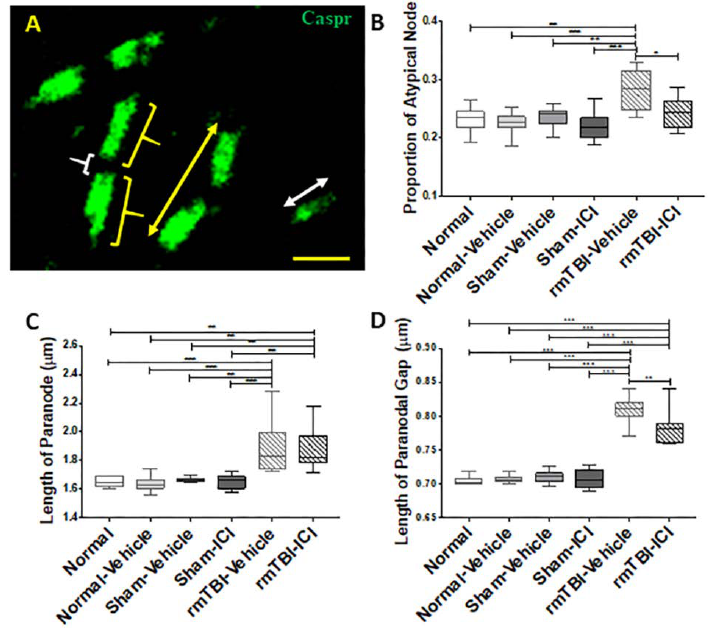
Figure 6. Analysis of the node of Ranvier integrity in the corpus callosum on day 11 following mTBI on days 1 and 2. ( A ) Representative image of Caspr immunofluorescence in the splenium of the corpus callosum shows the measures used in the analysis, including the node of Ranvier complex (yellow arrow), atypical node (white arrow), paranode (yellow bracket), and paranodal gap (white bracket); scale bar = 2 μm. ( B ) Proportion of atypical nodes, ( C ) length of paranode, and ( D ) length of paranodal gap are shown as median, interquartile range, and range. * p < 0.05, ** p < 0.01, *** p < 0.001, one-way analysis of variance with Bonferroni post-hoc comparisons.